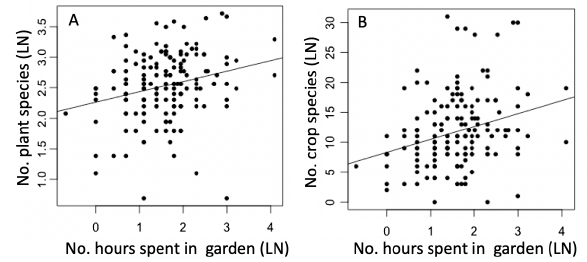
Fig. 1 . Significant predictors of total plant (A) and crop (B) species richness reported by gardeners in urban gardens in the California central coast as determined with generalized linear mixed models (GLMM) selection. In scatter plots, lines show the best fit